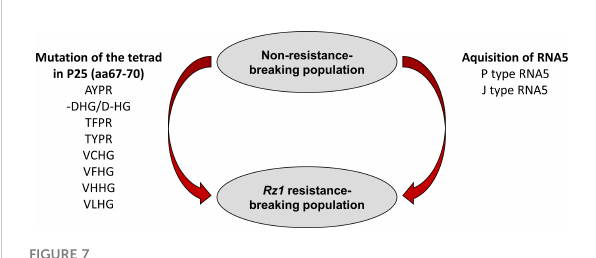
FIGURE 7 Scheme illustrating the resistance-breaking mechanisms utilized by BNYVV to overcome Rz1